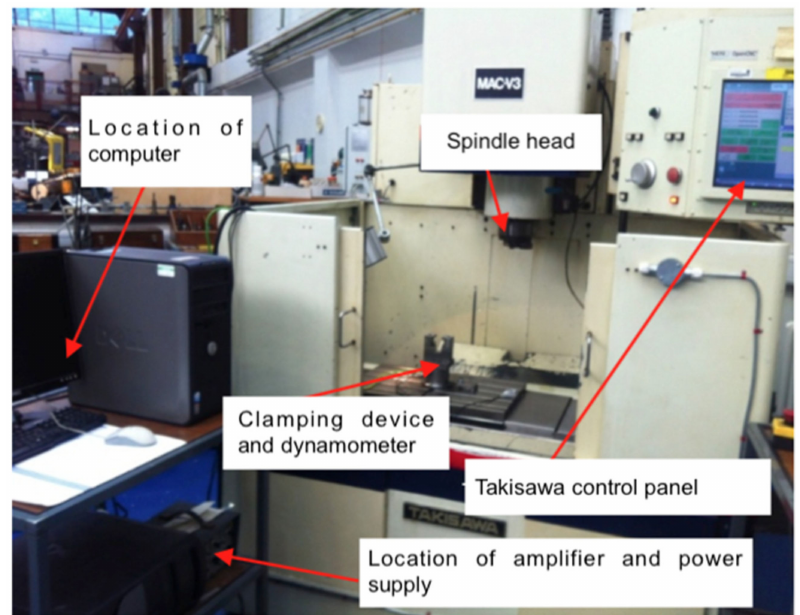
Figure 1. Takisawa MAC-V3 CNC machining centre.